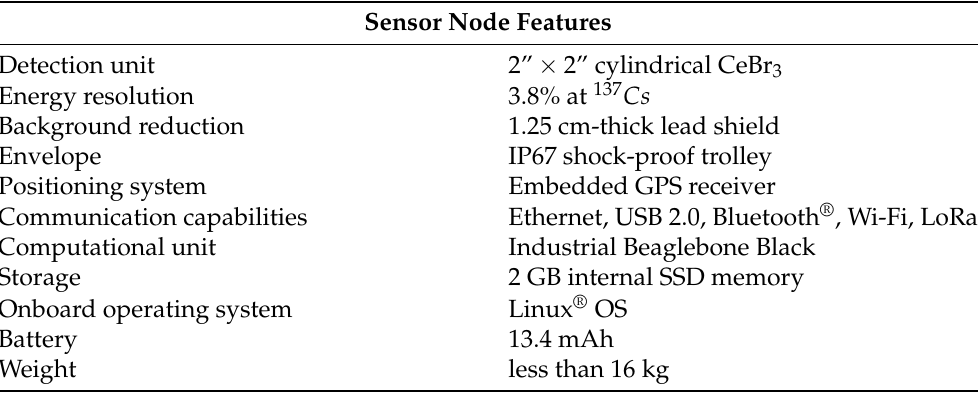
Table 2. List of the main features of CORSAIR sensor node detector and computational